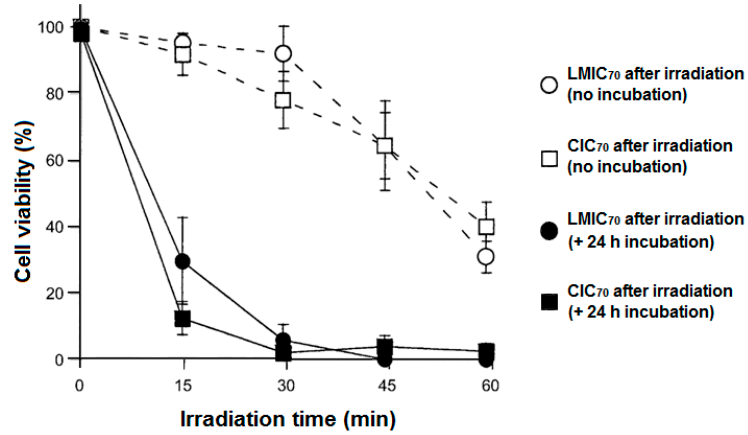
Figure 64. HeLa cell viability as a function of irradiation time ( λ > 400 nm at 35 °C). Cells treated with LMIC 70 and CIC 70 and stained with propidium iodide immediately after irradiation and subsequent 24 h incubation ( n = 3). Adapted from Ikeda; Nagano; Akiyama; Matsumoto; Ito; Mukai; Hashizume;